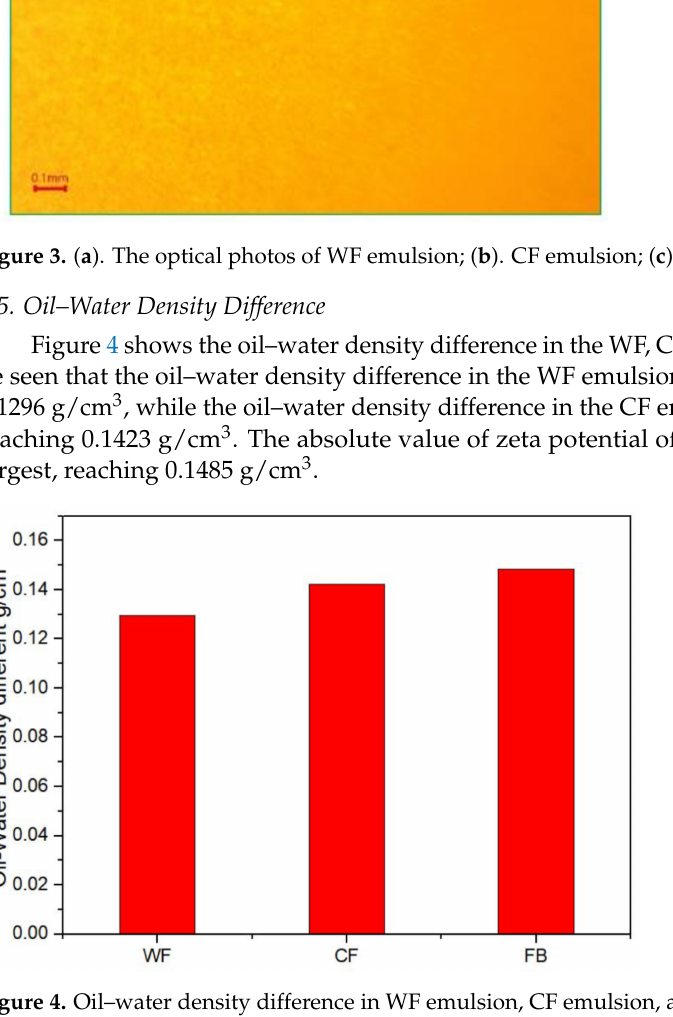
Figure 4. Oil–water density difference in WF emulsion, CF emulsion, and FB